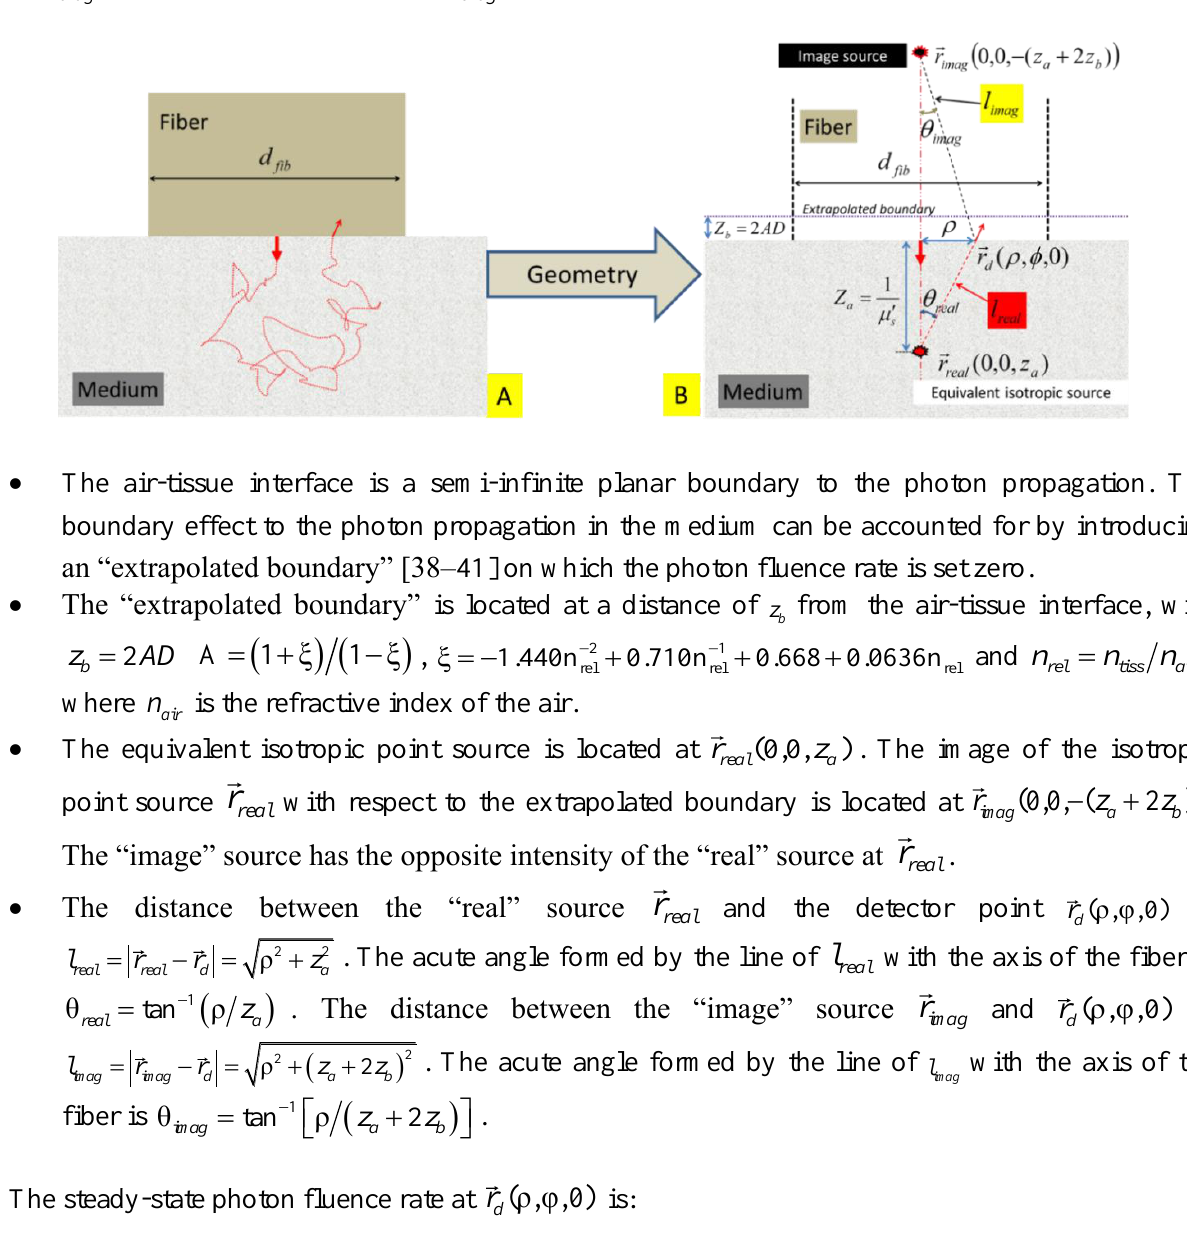
Figure 3. ( A ) Schematic of an idealized geometry for placing a fiber with a diameter of and a straight-polished tip at the surface of a turbid medium. The same fiber is used for launching light into and collecting light from the medium. A dual-point configuration approximates the light leaving and returning to the fiber. ( B ) The light that is initially directionally-launched into the medium is represented by an equivalent isotropic source  zr that is located at ),0,0( . The distance between the equivalent source areal detector point , and the acute angle formed by the line of to the axis of the fiber is θ . An “extrapolated” boundary is located at real physical boundary of the medium. The image of the